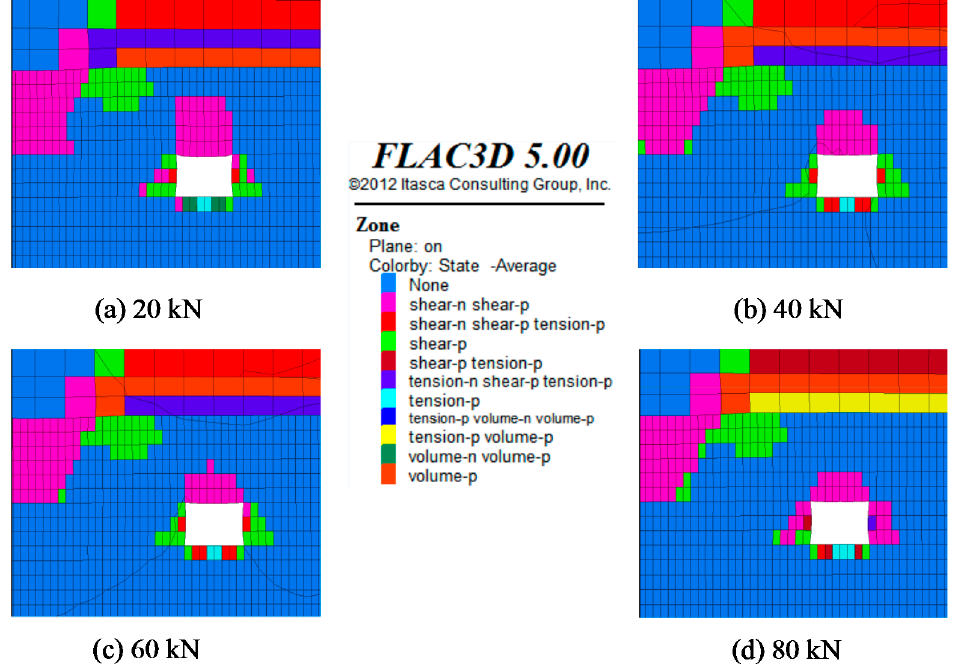
Figure 15. Range of the plasticity zone of the roadway with different tightening forces.